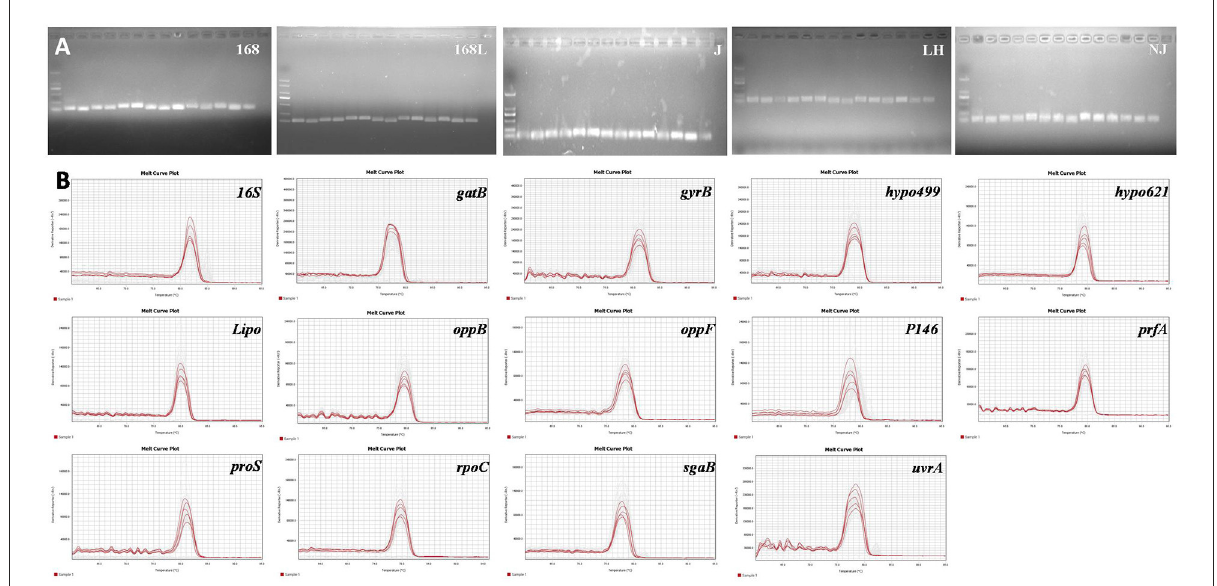
FIGURE1 (A) . Nucleic acid gel electrophoresis of candidate reference genes. M: DL2000;1: 16S ; 2: gyrB ; 3: gatB ; 4: hypo499 ; 5: hypo621 ; 6: Lipo ; 7: oppB ; 8: oppF ; 9: P146 ; 10: prfA ; 11: proS ; 12: rpoC ; 13: sgaB ; 14: uvrA. (B) . Melting curves of the 14 candidate reference genes using genomes